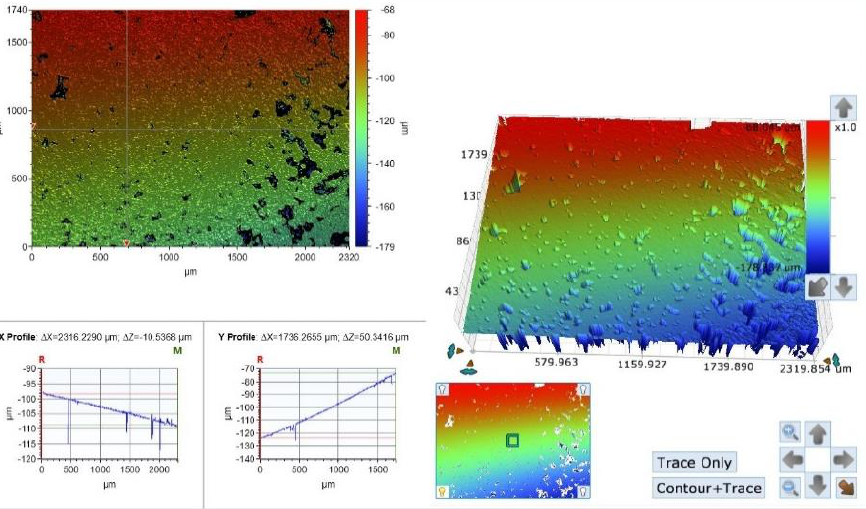
Figure 4. A surface scan photograph and a topography graph of a control group sample. Great variations were found between the different samples: smooth areas with occasionally high hills and deep pits.